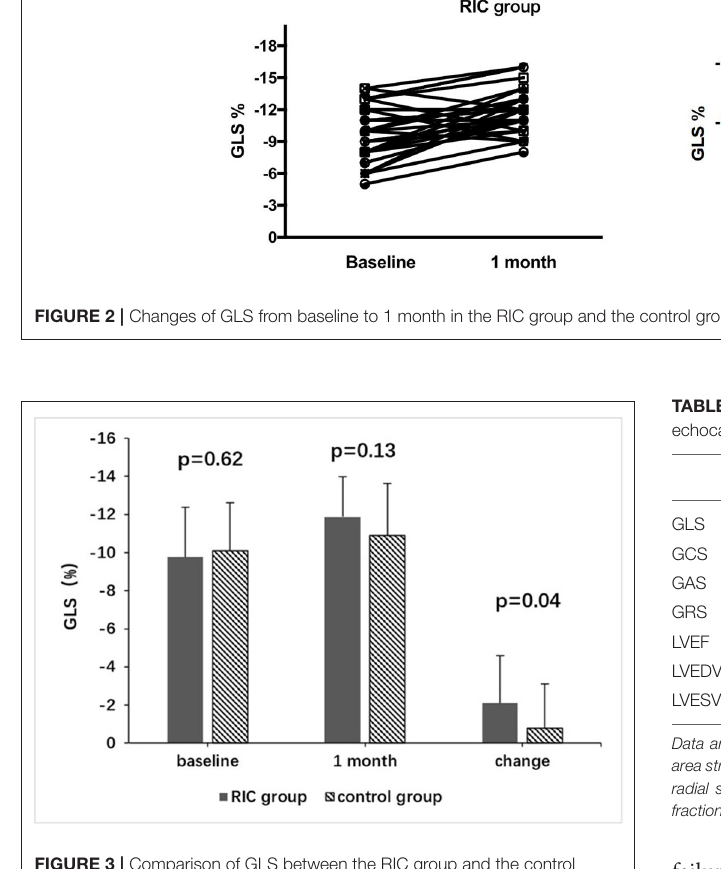
FIGURE 3 | Comparison of GLS between the RIC group and the control group. GLS, global longitudinal strain; RIC, remote ischemic conditioning.